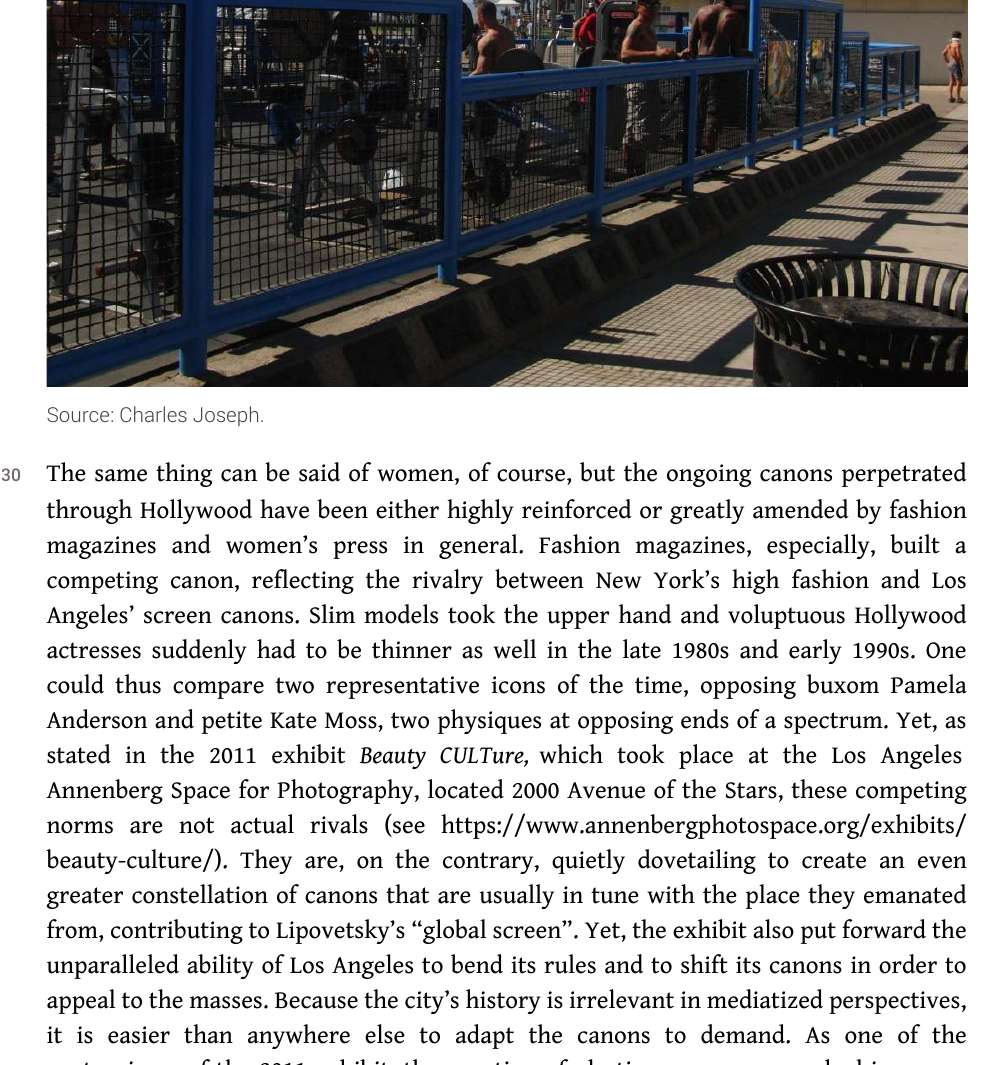
Figure 10: Open-air gym on the beachfront, where passers-by can admire the bodybuilders’ physique